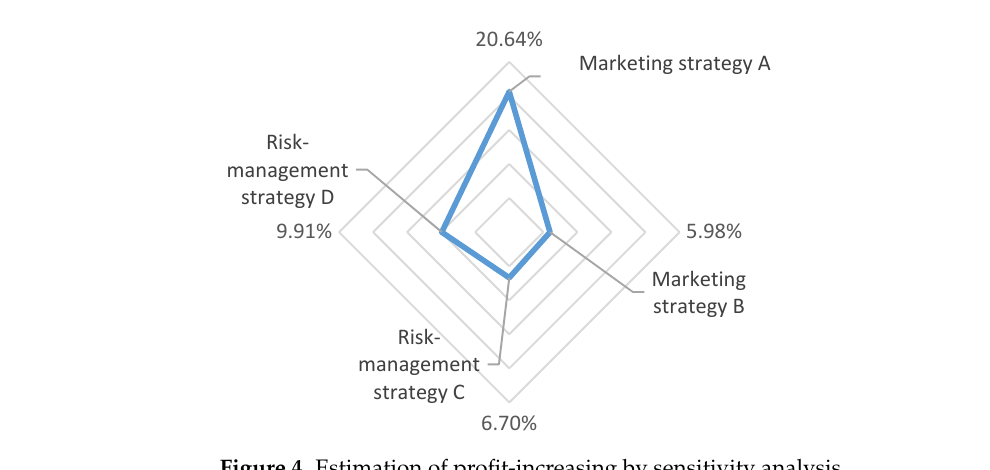
Figure 4. Estimation of profit-increasing by sensitivity analysis.